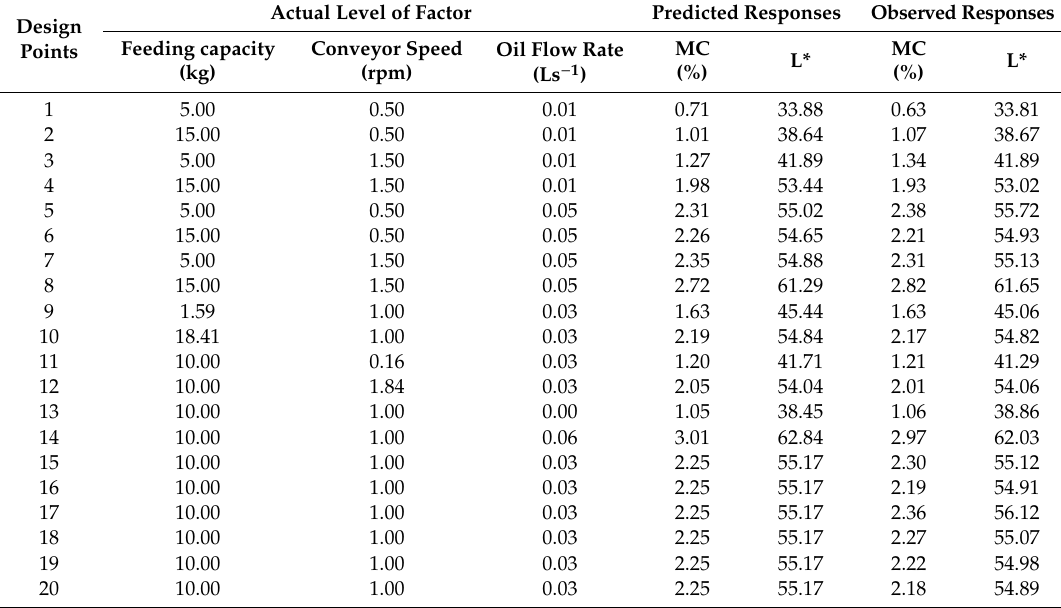
Table 2. Central composite response design (CCRD) of experiment for quadratic response surface analysis on MC and